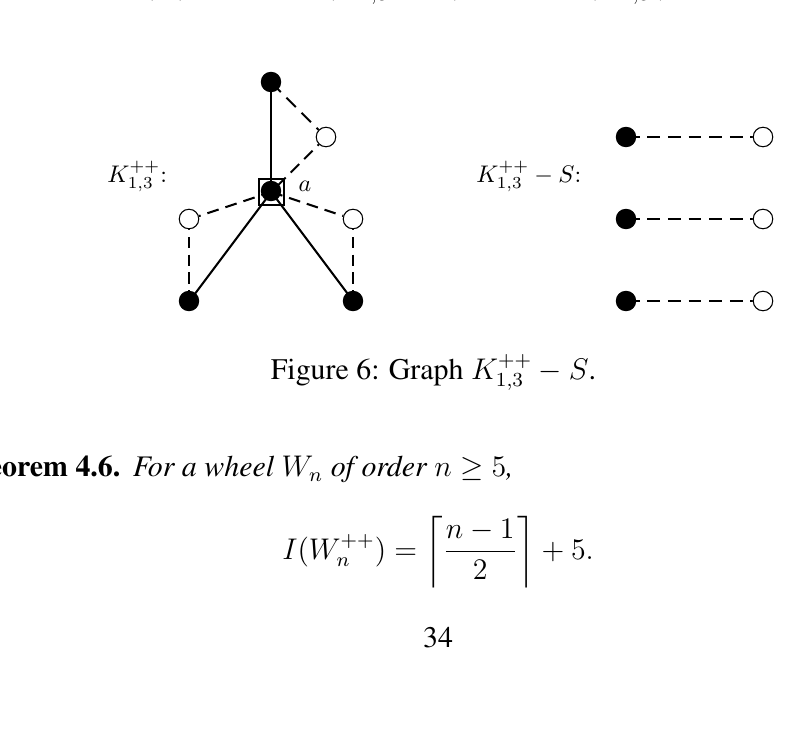
Figure 6: Graph K ++